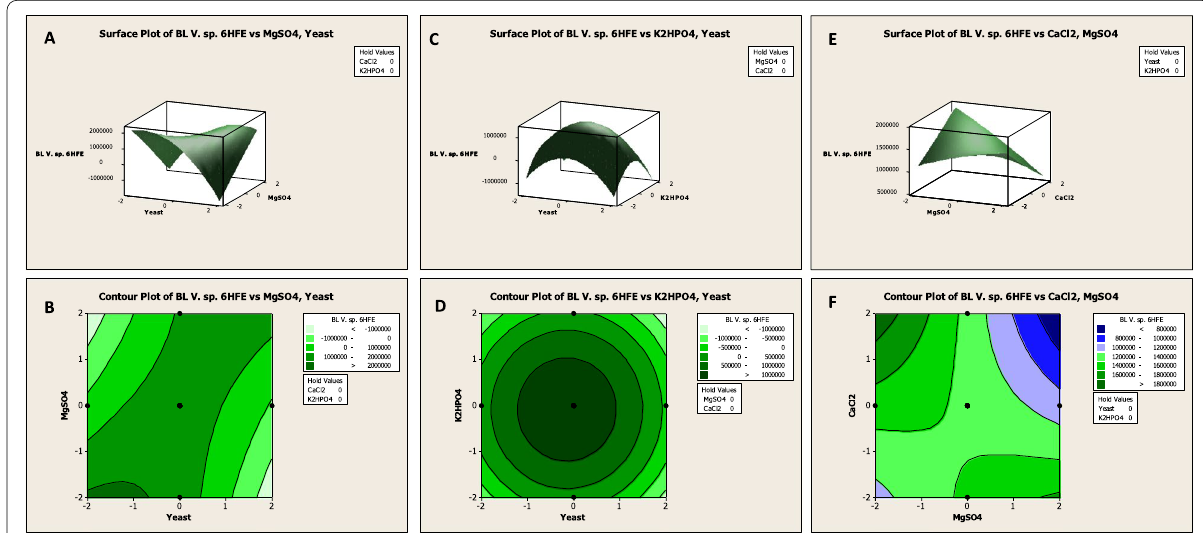
Fig. 6 3D surface plot (left panels) and 2D contour plot (right panels) displaying the mutual effects of independent significant variables on bioluminescence